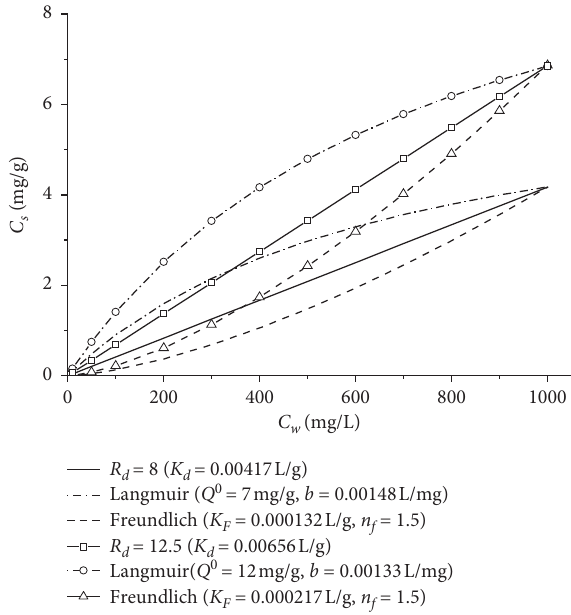
Figure 2: The adsorption